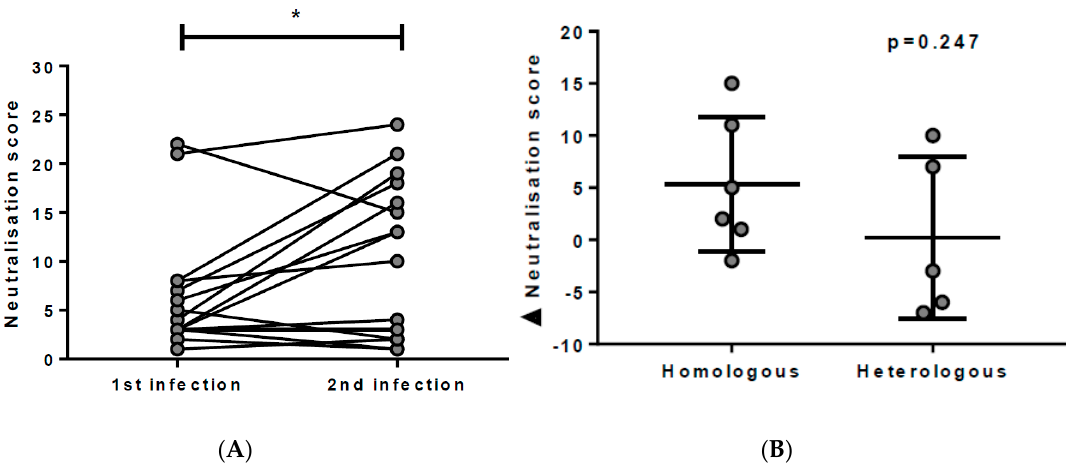
Figure 5. Comparison of neutralisation scores between primary and secondary infections. ( A ) Neutralisation scores in acute secondary infections were found to be significantly higher than acute primary infections ( p = 0.0494, Wilcoxon t -test). ( B ) The difference in neutralisation scores between primary and secondary infections in homologous and heterologous reinfections was not found to be significant ( p = 0.247, Mann–Whitney t -test). Subject 300089 was excluded from this analysis, due to incident mixed primary infection.